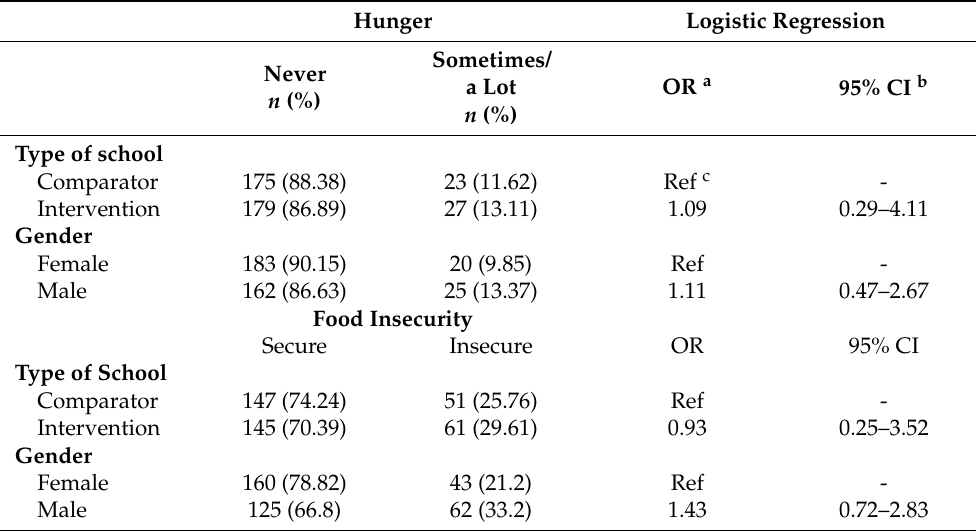
Table 4. Results of the student survey showing univariable logistic regressions of the impact of UFSM on student hunger and food